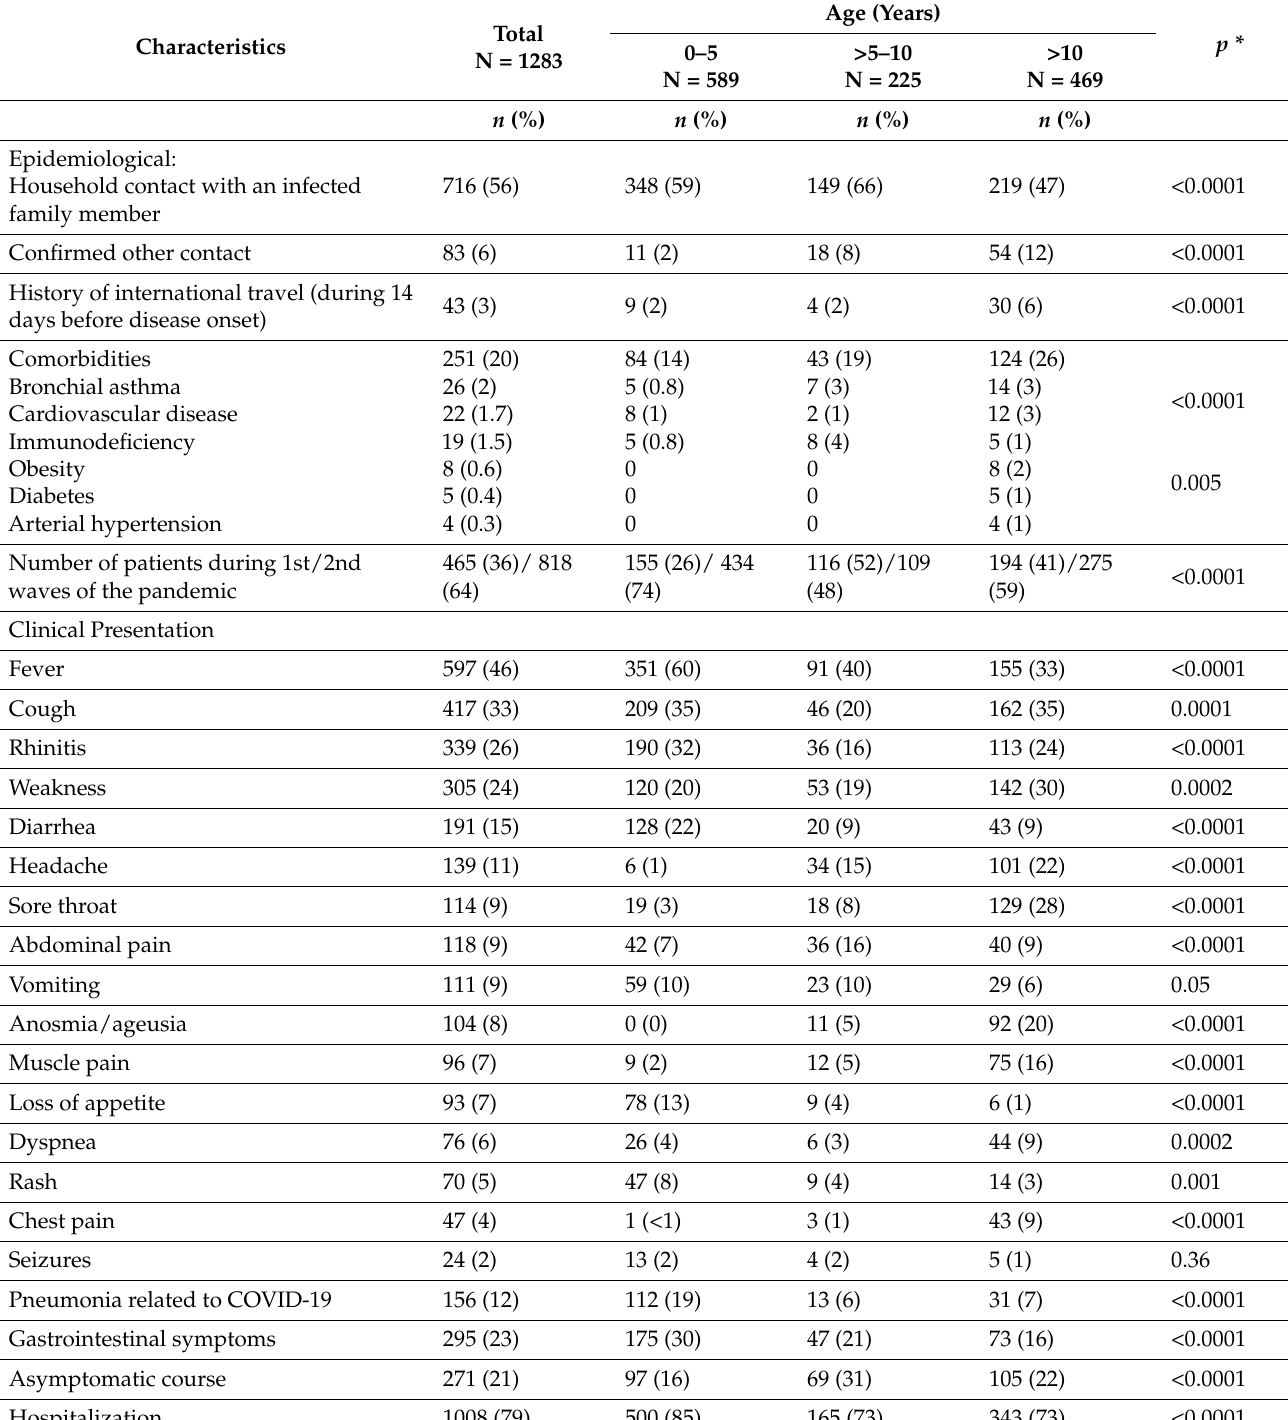
Table 1. Clinical presentation and epidemiological characteristics of COVID-19 in the study group and in different age